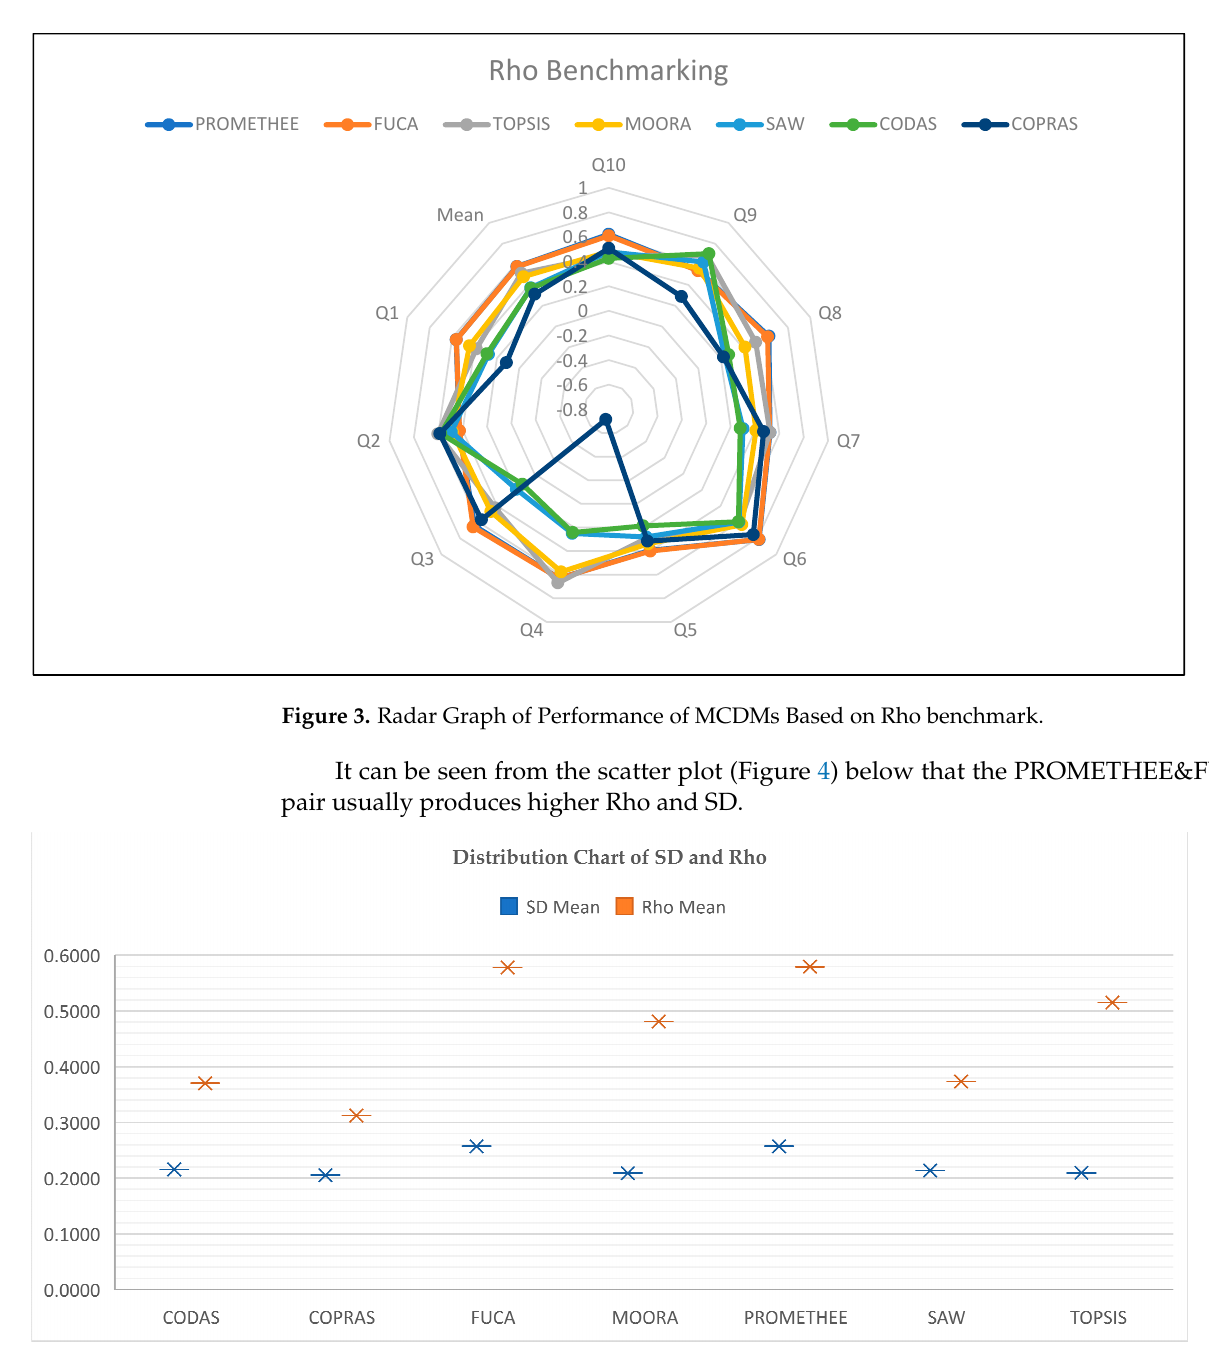
Figure 4. Distribution Plot of Rho and SD Data.